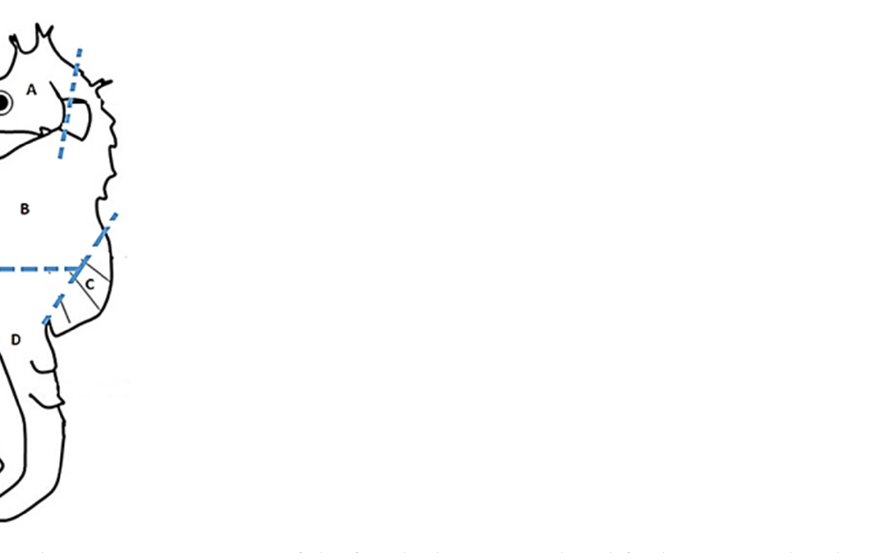
Figure 1. Schematic representation of the four body parts analyzed for long-snouted seahorse ( Hippocampus guttulatus ). A —head, B —trunk, C —dorsal fin and D —tail.